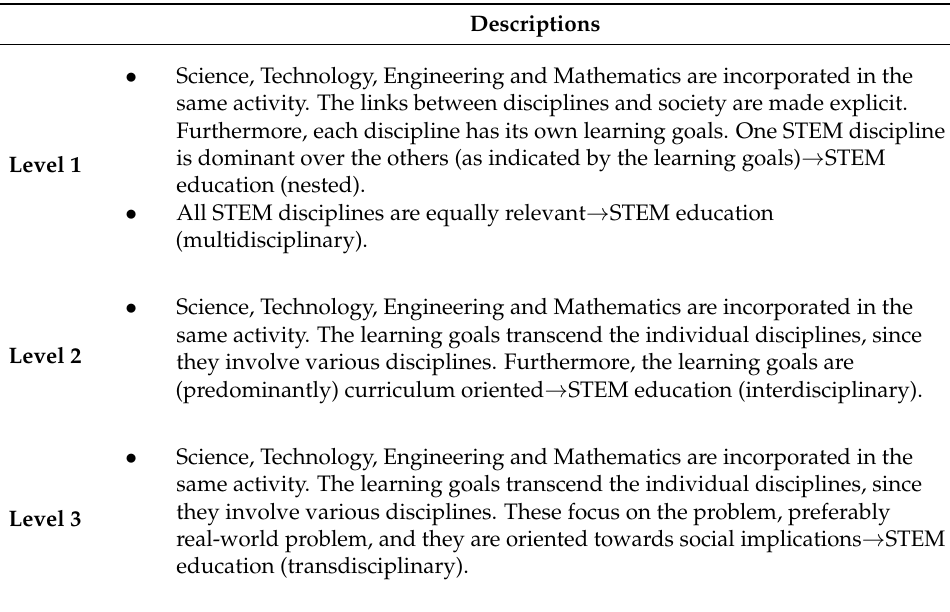
Table 1. Levels of integration of the STEM (Science, Technology, Engineering, and Mathemat- ics)